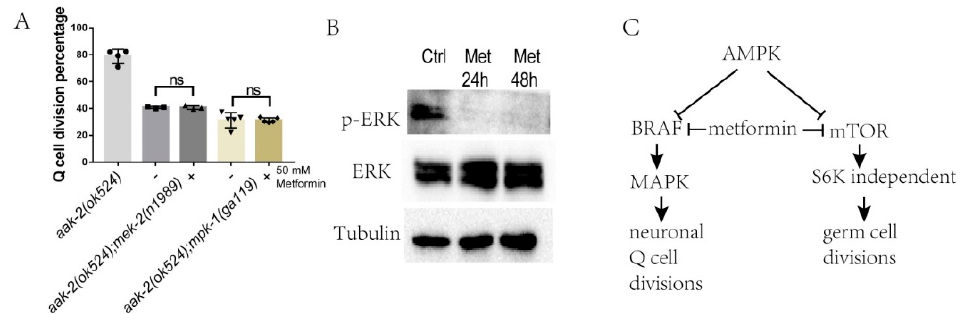
Figure 6. Metformin suppresses Q-cell divisions through BRAF-MAPK. ( A ) mpk-1/MAPK mutation blocks the suppression effect of metformin on Q-cell divisions in aak-2(ok524) mutants. -: no metformin treatment, +: 50 mM metformin was added. Data are the average of 3–5 independent experiments. Error bars: standard deviation (SD). ( B ) Western blot analysis of ERK/MAPK phosphorylation levels in cells treated with 50 mM metformin. ERK/MAPK phosphorylation activity is reduced by metformin treatment. Ctrl: control, Met: 50 mM metformin. ( C ) A working model depicting the effect of metformin in L1-arrested worms. Metformin works through BRAF to block MAPK function in AMPK-deficient L1-arrested worms to suppress neuronal Q-cell divisions and might also work through mTOR to block germ-cell proliferation; however, the pathways by which metformin regulates cell divisions in these two tissues are